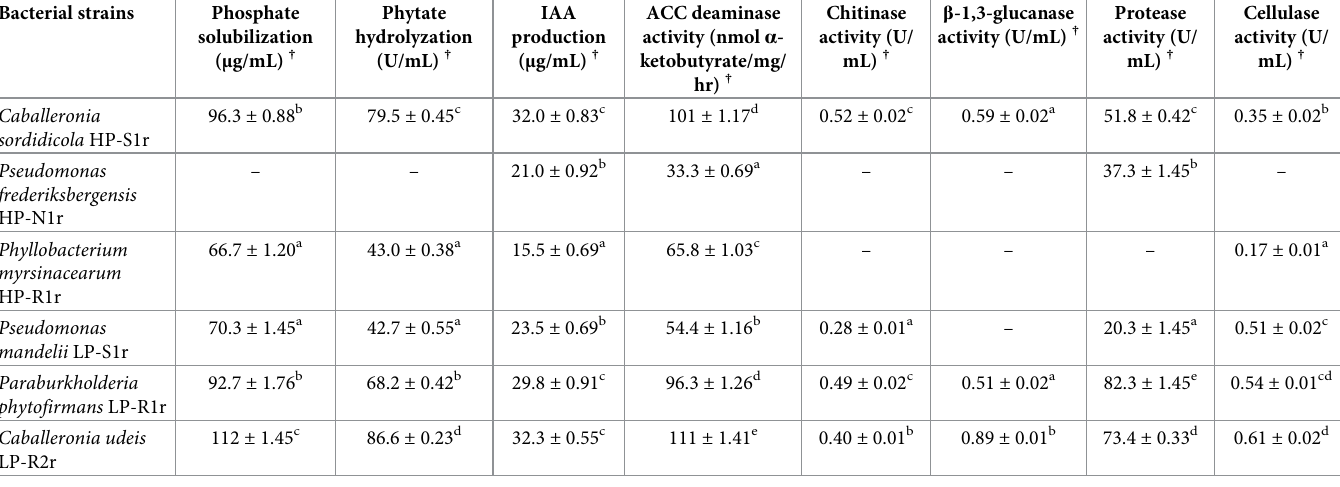
Table 2. Quantitative evaluation of major direct and indirect plant-growth-promoting mechanisms of the six bacterial strains using in vitro broth-based enzyme assays. Bacterial